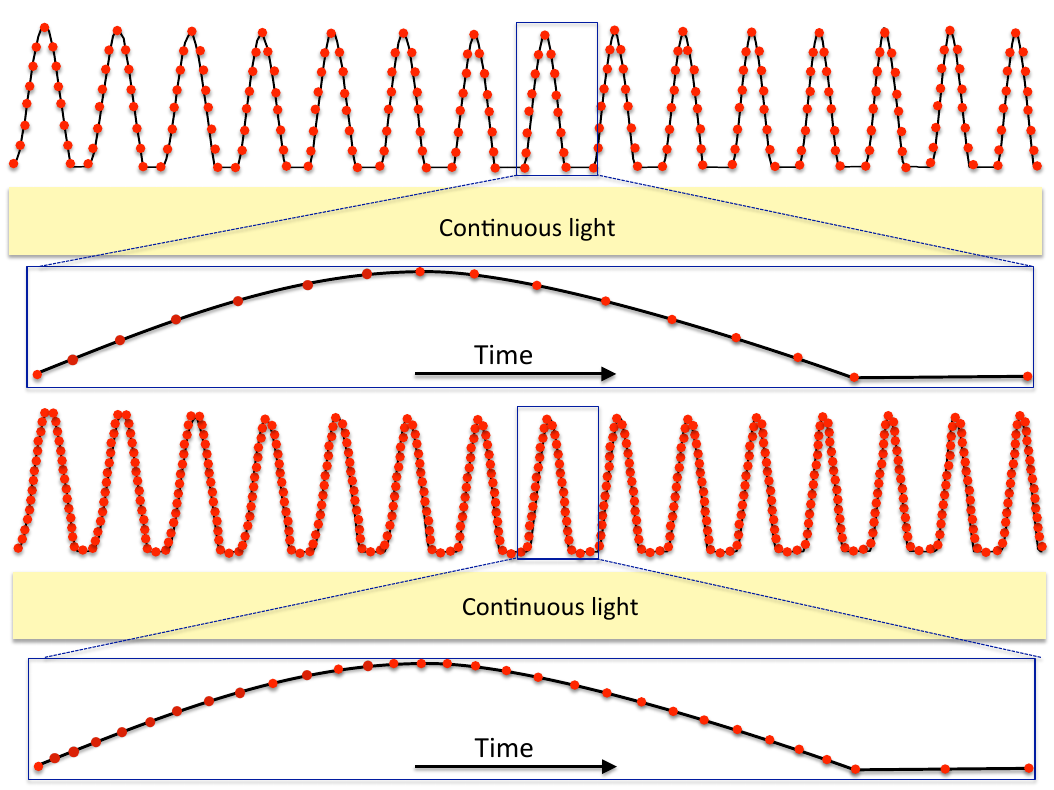
Figure 3. Illustrations of the Laryngeal High-Speed Videoendoscopy (HSV) sampling effect for two different frame rates. Adapted from